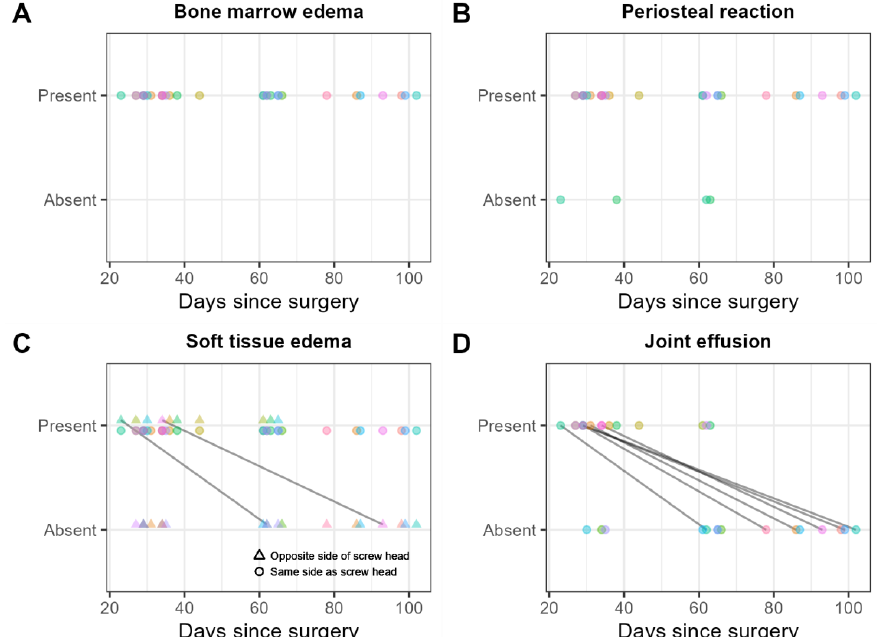
Figure 10. Consensus scores of the two readers on 30 MRI examinations for the presence/absence of ( A ) bone marrow edema in general, that is, whether adjacent to the screw or not in continuity with the edema adjacent to the screw; ( B ) periosteal reaction; ( C ) soft tissue edema in general, that is, whether on the same or the contralateral side of the screw head; and ( D ) joint effusion. Scores obtained from the same patient are shown in the same color. Solid black lines indicate within-patient changes over time. Pile-up artifacts were found in thirty (100%) examinations, of which twenty-six (87%) were minimal, and four (13%) were impairing diagnostic validity. Geometric distortion artifacts were found in zero (0%) examinations.